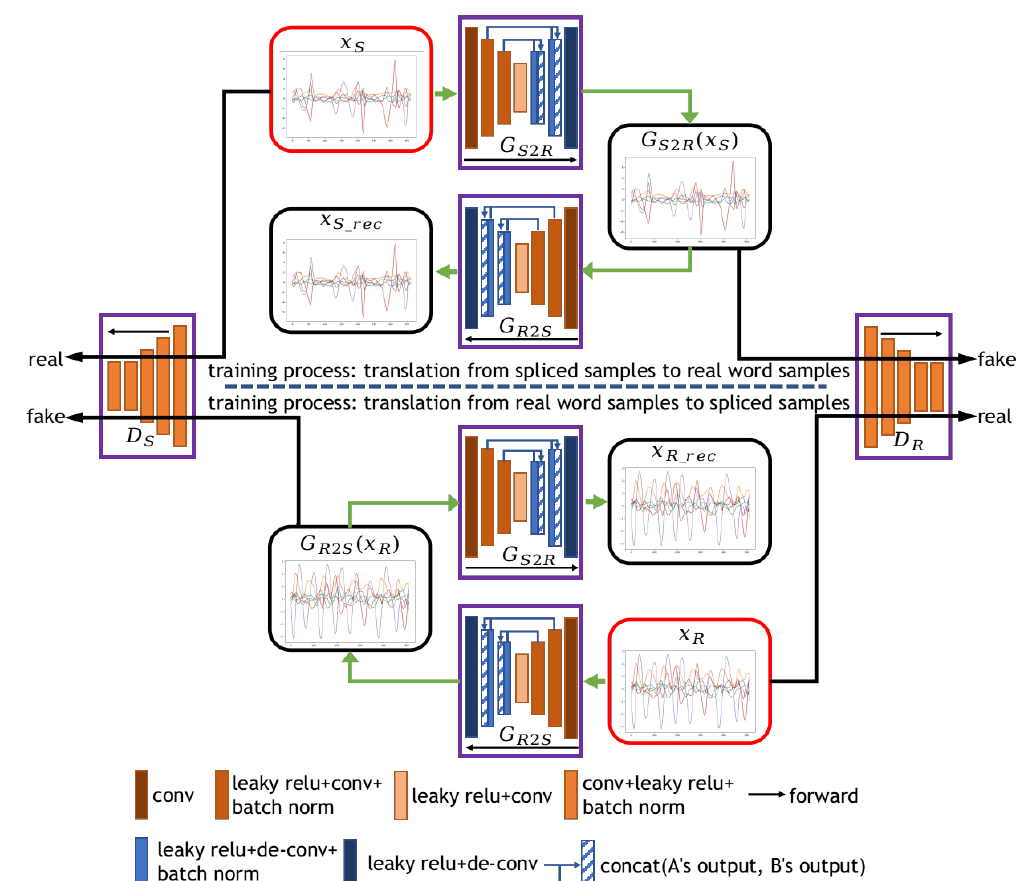
Figure 4. Training process of the generating module. The generating module refers to G S 2 R . x S and x R in the red boxes denote input samples from the spliced domain and the real word domain. G S 2 R denotes the generator that maps from S domain to R domain. G R 2 S denotes the generator mapping from R domain to S domain. D S and D R denote discriminators in each